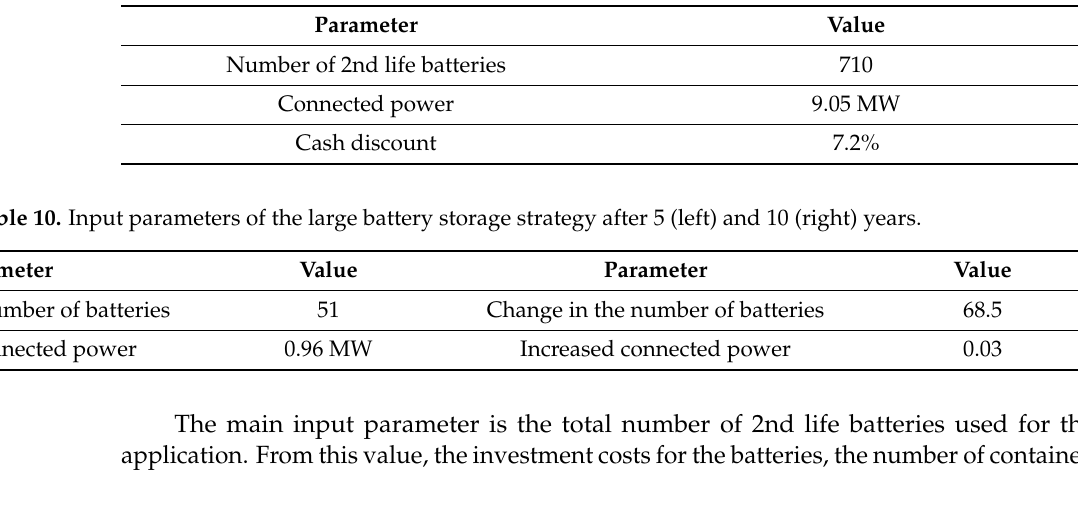
Table 9. Input investments.